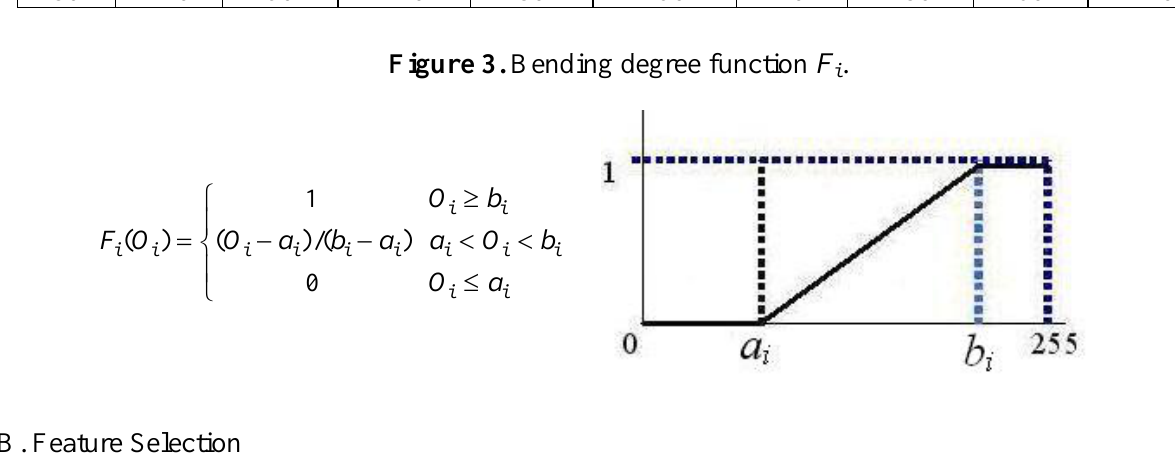
Figure 3. Bending degree function F